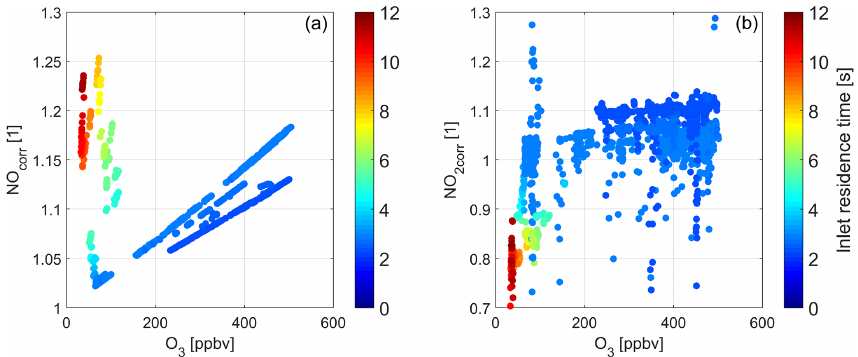
Figure 6. Typical correction factors for (a) NO and (b) NO 2 , which depend on ambient ozone and residence time (color bar) in the inlet manifold system, for one flight from DUS to NYC in June